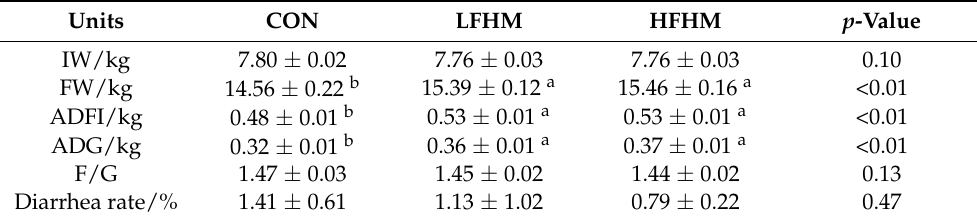
Table 2. Effects of different amounts of fermented Chinese herbal medicine on growth performance of weaned